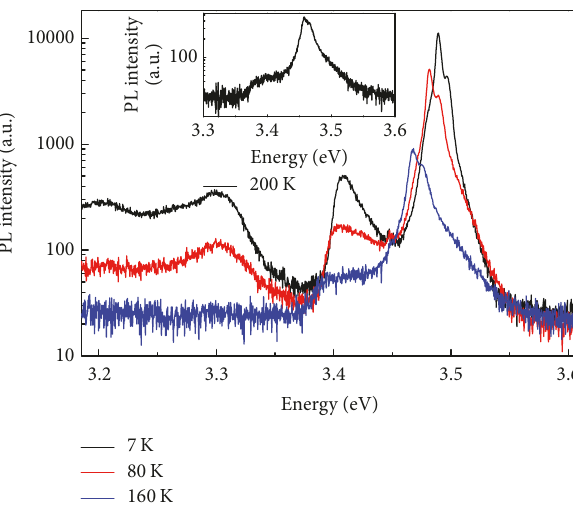
Figure 6: PL spectra of AlGaN/GaN heterostructure in the tem- perature range of 7 K to 160 K. The inset shows the PL spectrum of AlGaN/GaN heterostructure at 200